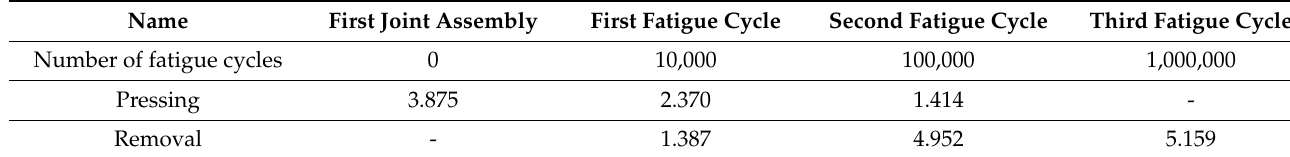
Table 4. Value of the maximum force needed for joint assembly and disassembly [kN].